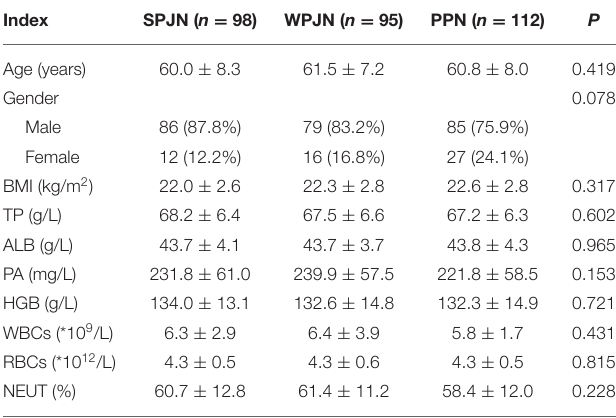
TABLE 2 | Baseline data of three groups of